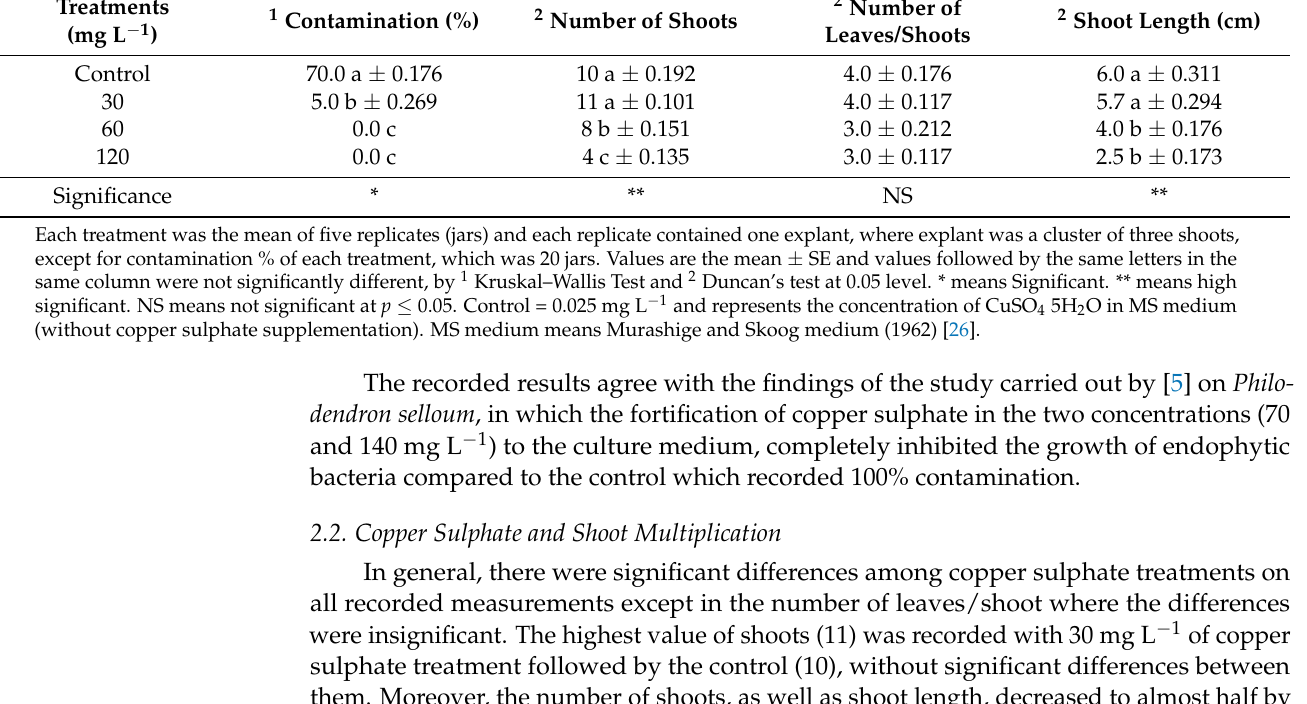
Table 1. Effect of different concentrations of copper sulphate on contamination % and shoot multiplication of banana plant after three subcultures, 3 weeks each in MS medium supplemented with 3 mg L − 1 BA + 1 mg L − 1 Kin.